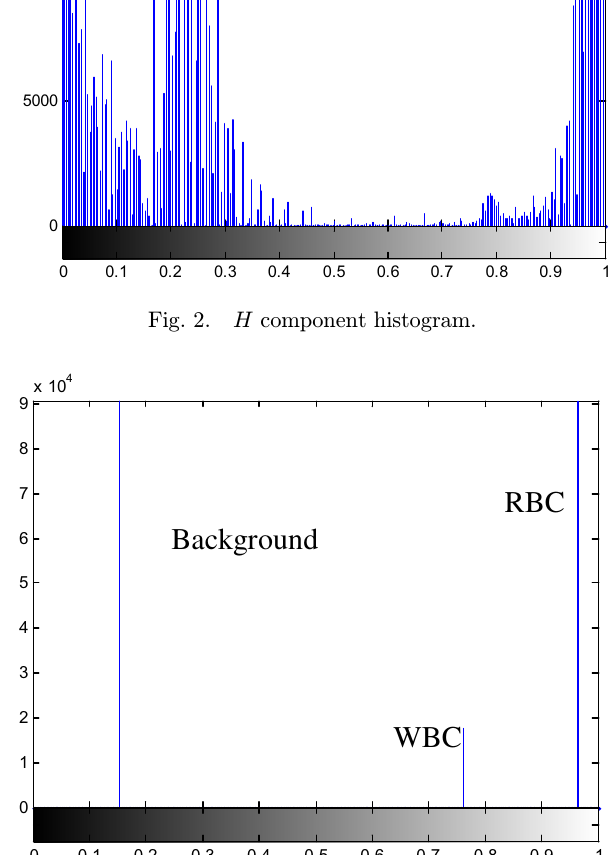
Fig. 3. K-means processing.